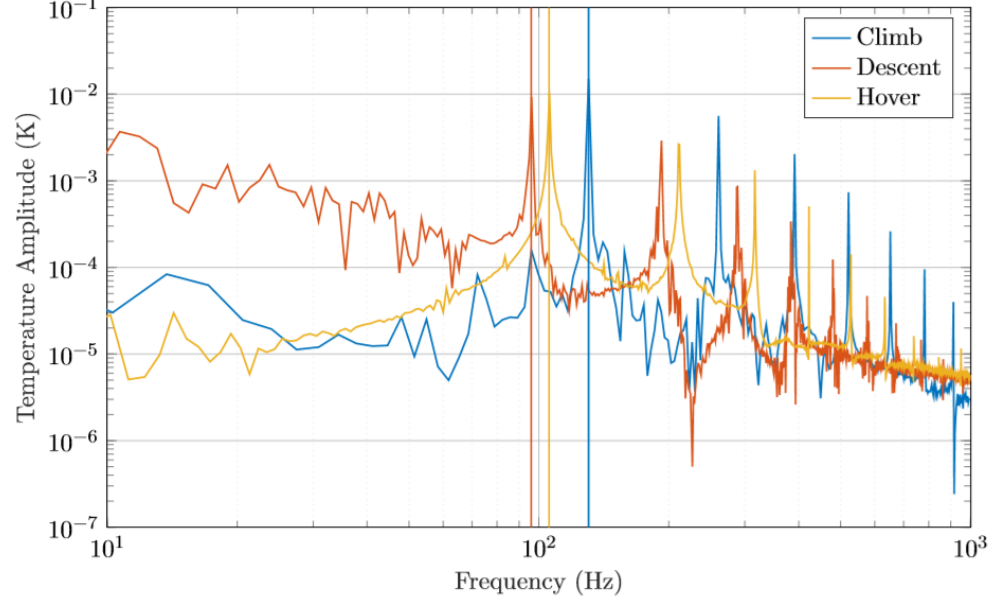
Figure 10. Simulations of temperature spectra (amplitude of temperature fluctuations over frequency) at the sensor location for climb (blue), descent (orange) and hover (yellow). The vertical lines represent the first harmonics of the blade rotational speed in the respective